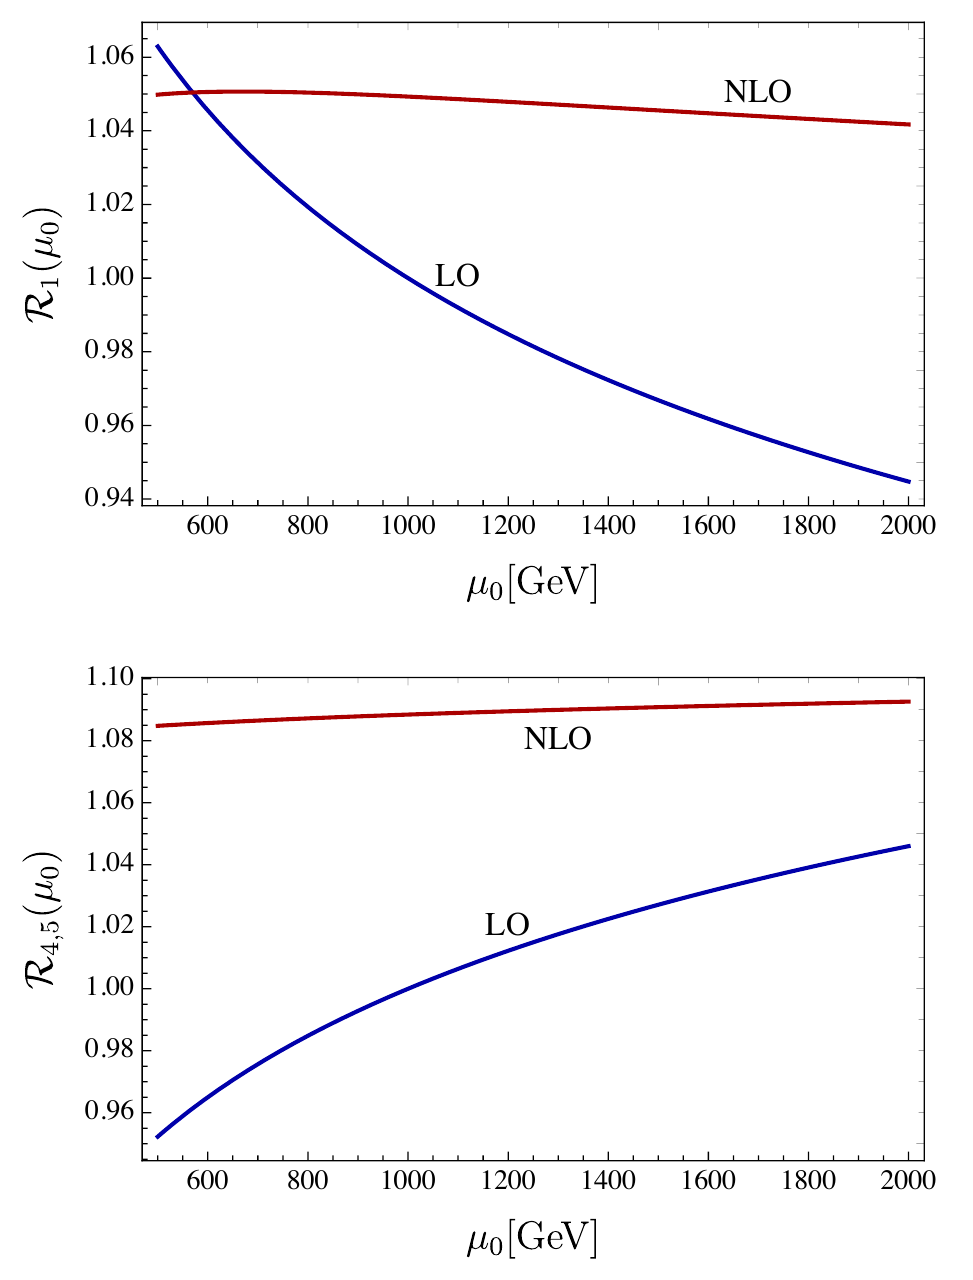
Figure 4 . Matching-scale dependence of the ratios R 1 and R 4 , 5 for M (1 TeV) = 1 TeV . The upper plot shows the case in which C 1 is generated (the Γ R Γ R contribution to the mass difference), while the lower plot shows the case in which C 4 and C 5 are generated (the Γ L Γ R contribution to the mass